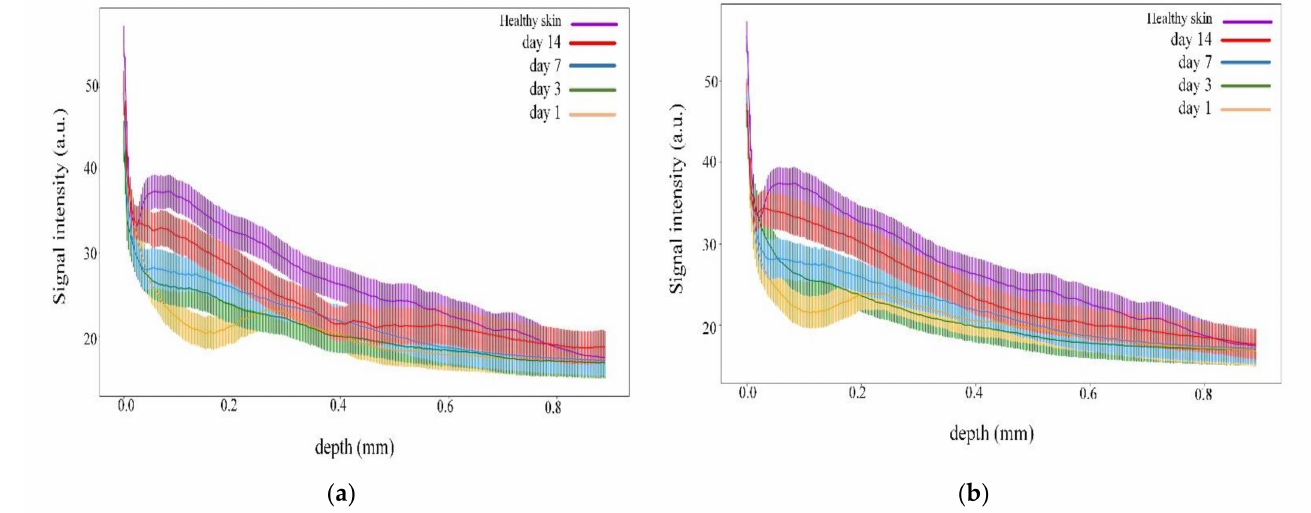
Figure 12. Dependence of signal intensity on depth for the ( a ) LDPDT-MB 1 J/cm 2 group and ( b ) LDPDT-MB 4 J/cm 2